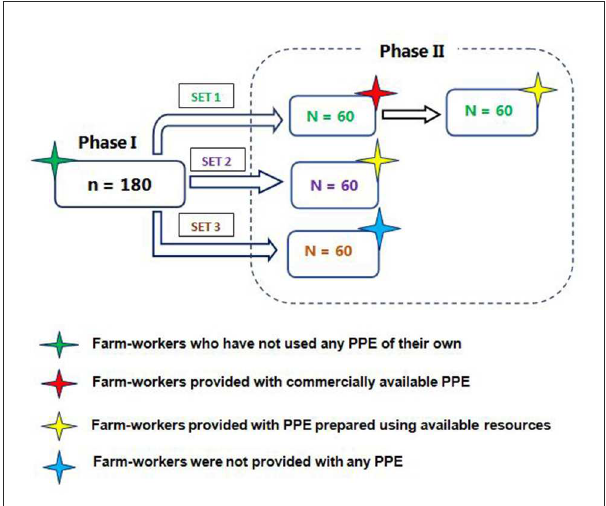
FIGURE1 Distribution of subjects in first and second phase of the